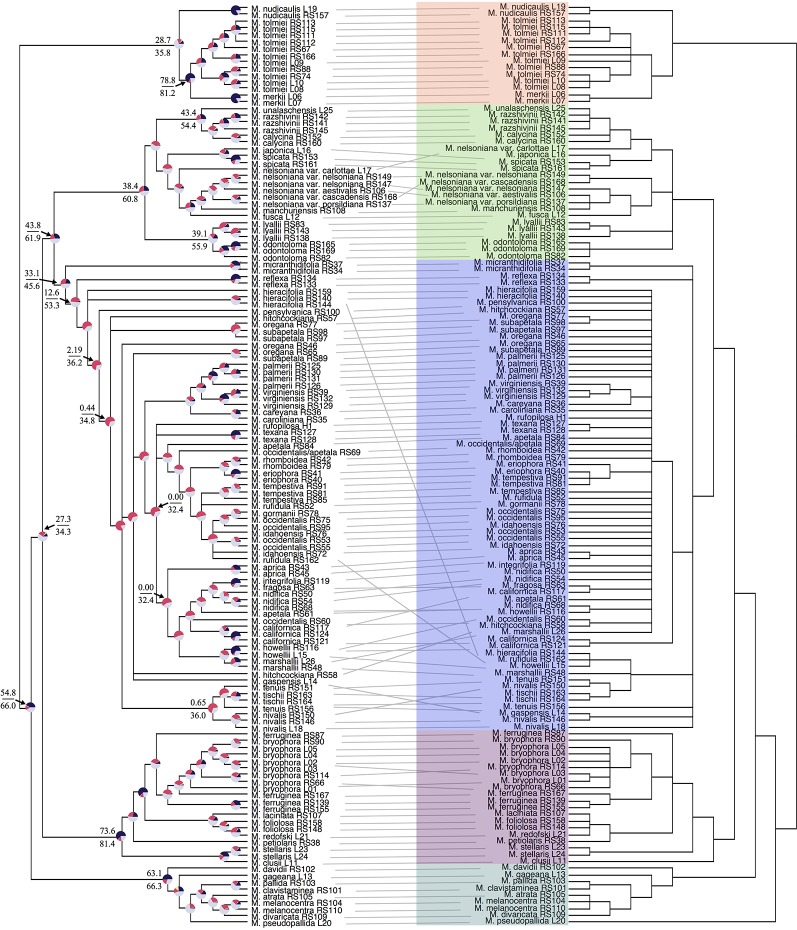
Tanglegram comparing ASTRAL-II nuclear species tree (left) and the RAxML plastid topology (right). Branches with less than 0.7 local posterior probability (LPP) or 70% bootstraps (BS) are collapsed. Clades are colored corresponding to Figure 1. Pie charts at nodes on ASTRAL-II tree show gene tree conflict evaluations at each node as the following: proportion of gene trees in concordance (blue), in conflict (pink), agreeing with the dominant alternative topology (yellow), and unsupported with less than 70% BS (gray). Select nodes also include the gene (above) and site (below) concordance factors. All concordance factors shown in Supplementary Figure S6.